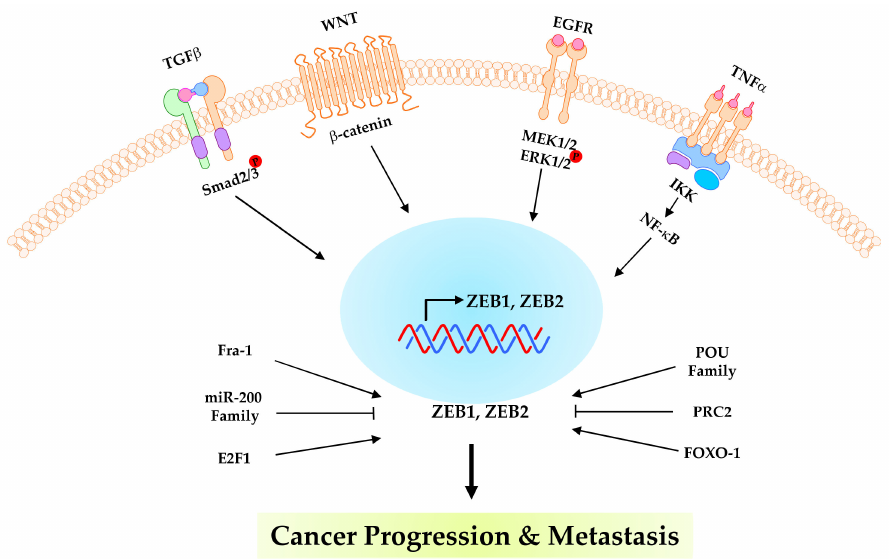
Figure 2. Mechanisms of ZEB family in cancer progression and metastasis. EGFR, WNT, tumor necrosis factor-a (TNFa), transforming growth factor beta (TGF-b), Fos-related antigen 1 (Fra-1), miR-200 family, POU family, PRC2 and FOXO-1 trigger expression of ZEB1 proteins. As a result, the ZEB family controls cancer progression and